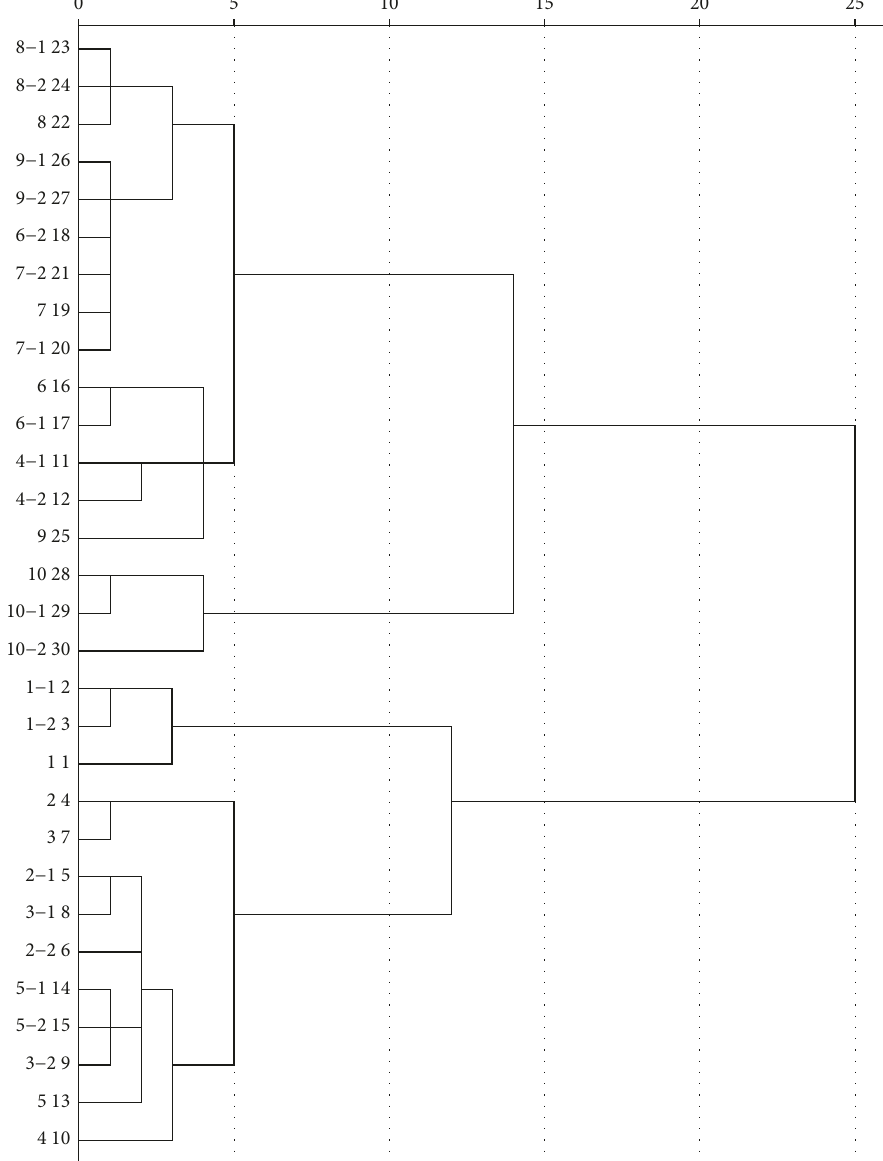
Figure 3: Hierarchical cluster analysis (HCA) of nonirradiated and irradiated saffron. Note. n : nonirradiation group; n -1:10kGy irradiation for 5h; n -2: 10kGy irradiation for 10h ( n 1–10, number of the 10 batches of (cid:31)